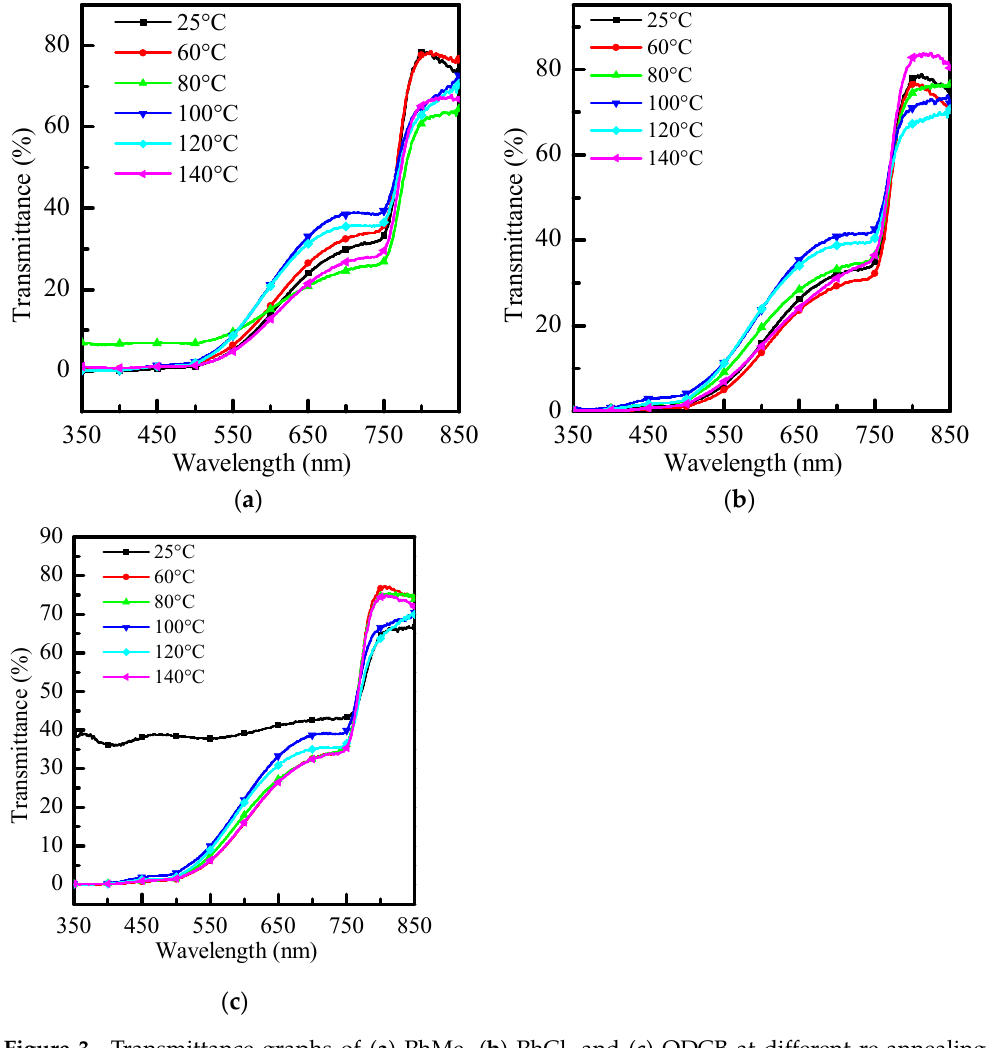
Figure 3. Transmittance graphs of ( a ) PhMe, ( b ) PhCl, and ( c ) ODCB at different re-annealing temperatures, respectively.